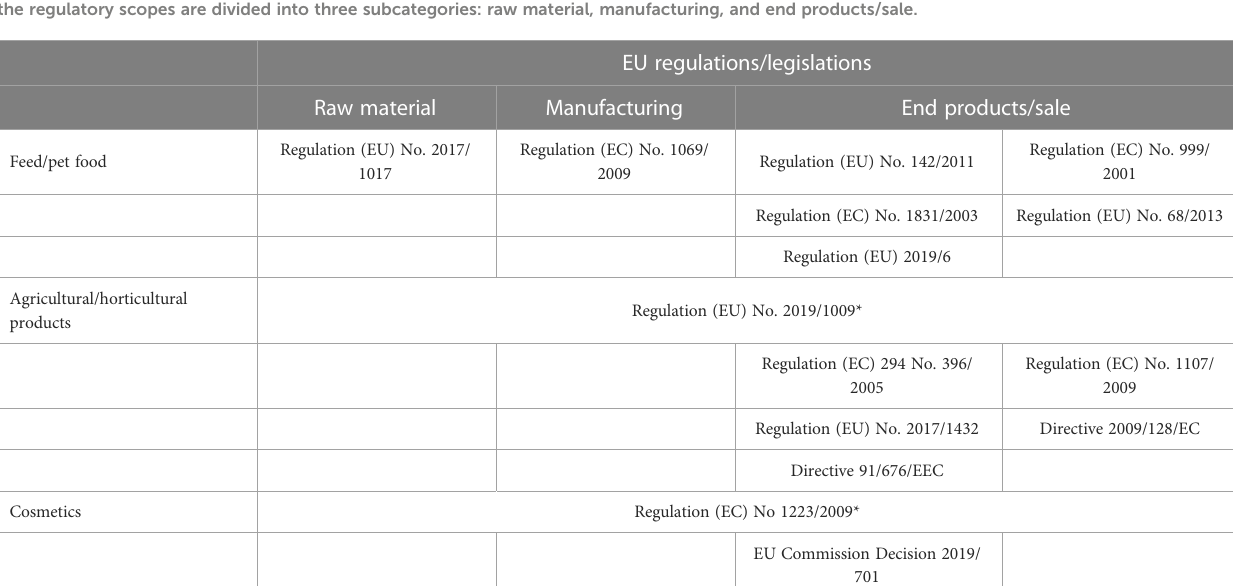
TABLE 4 Outline of the relevant EU regulations/legislations on three applications: feed/pet food, agricultural/horticultural products, and cosmetics; the regulatory scopes are divided into three subcategories: raw material, manufacturing, and end